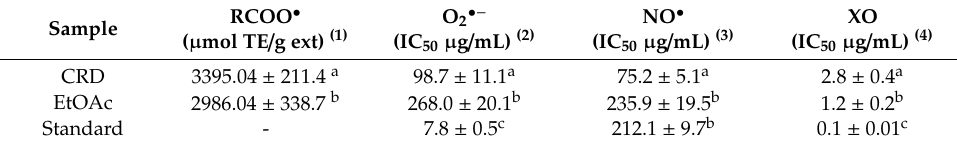
Table 1. Antioxidant activities of F. vesiculosus crude extract, ethyl acetate fraction and the respective reference